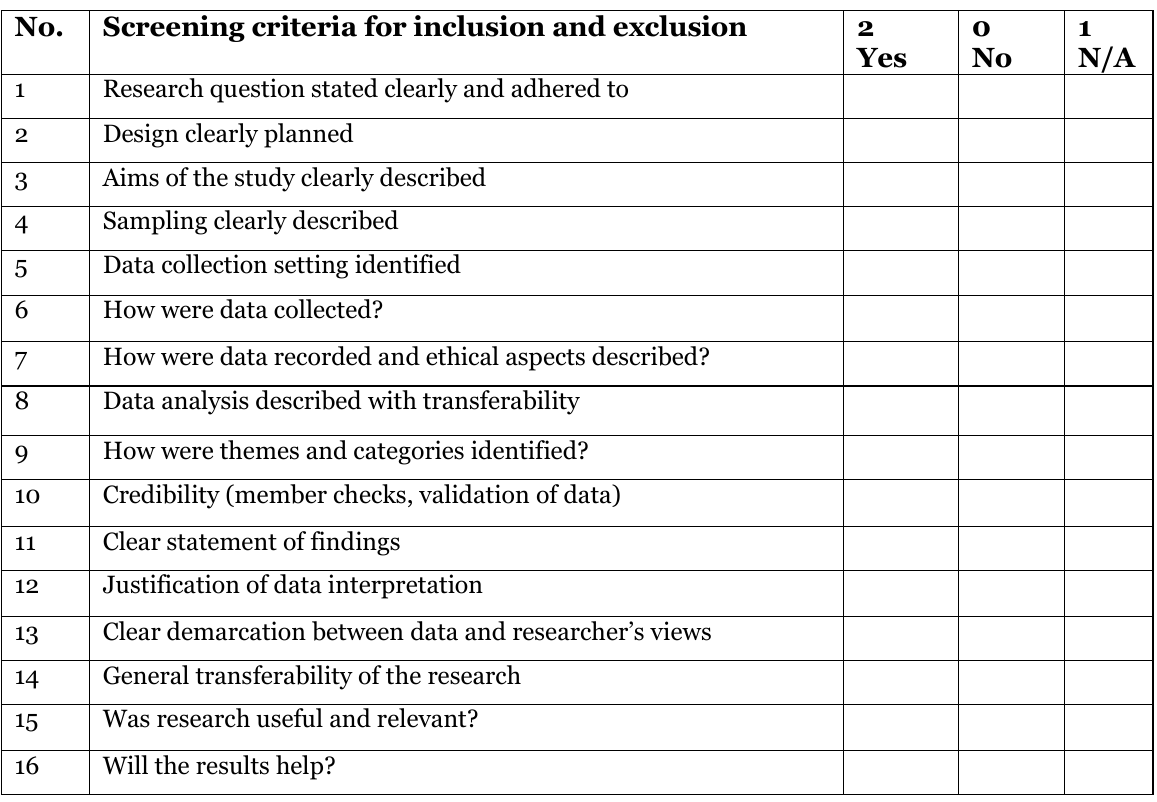
Table 1 Screening Criteria (Adapted from Paterson et al.,